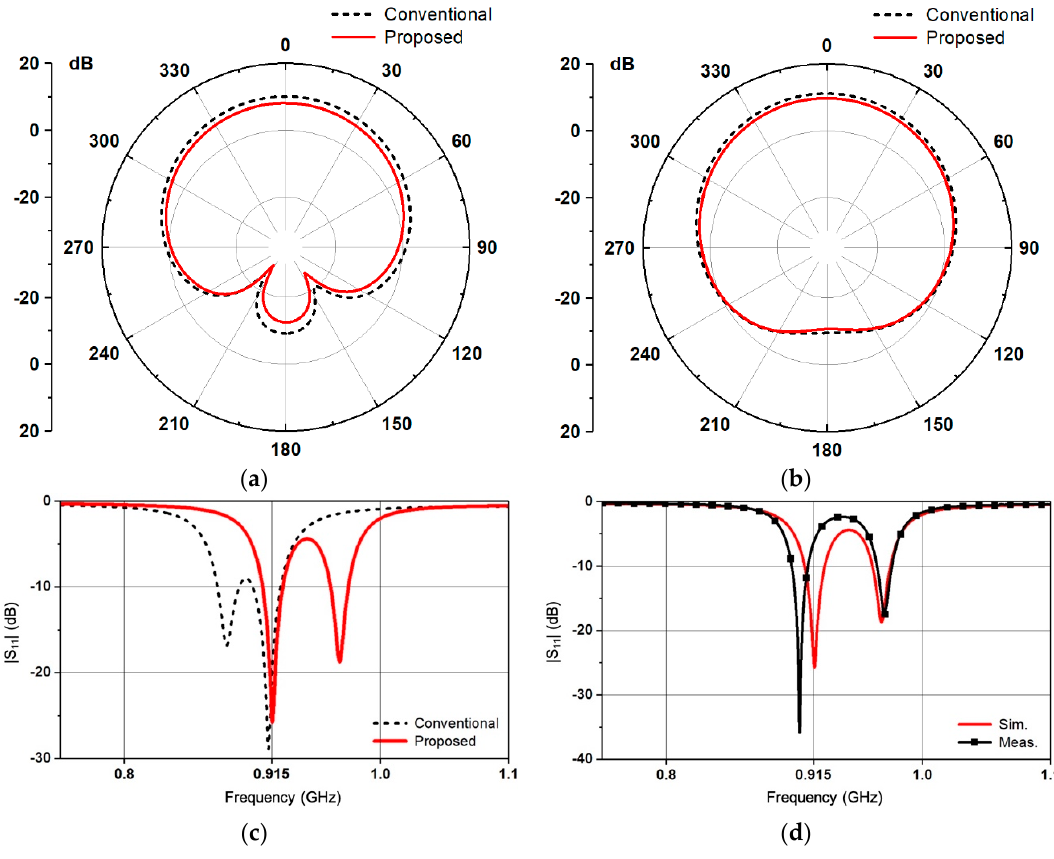
Figure 4. Performances of the conventional antenna and proposed antenna with the fractal-slot: ( a ) simulated E-plane radiation patterns at 915 MHz; ( b ) simulated H-plane radiation patterns at 915 MHz; ( c ) simulated S 11 in magnitude; ( d ) simulated and measured magnitudes of S 11 of the proposed antenna.